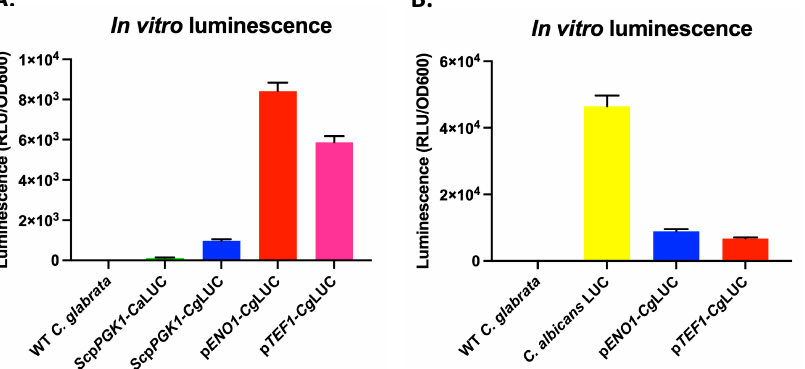
Figure 2. In vitro luminescence of different red-shifted luciferase constructs expressed in C. glabrata . Luminescence of in vitro grown early exponential phase cells was measured immediately upon injection of D-luciferin. ( A ) Comparison of the non-codon-adapted luciferase ( Ca LUC) to the codon- adapted luciferase ( Cg LUC) expressed from either the S. cerevisiae PGK1 promoter ( Sc p PGK1 ), the C. glabrata ENO1 promoter (p ENO1 ), or the C. glabrata TEF1 promoter (p TEF1 ). ( B ) A comparison between the two best constructs in C. glabrata and the C. albicans luminescent strain ( C. albicans LUC) used by Dorsaz et al. [17]. All error bars show standard